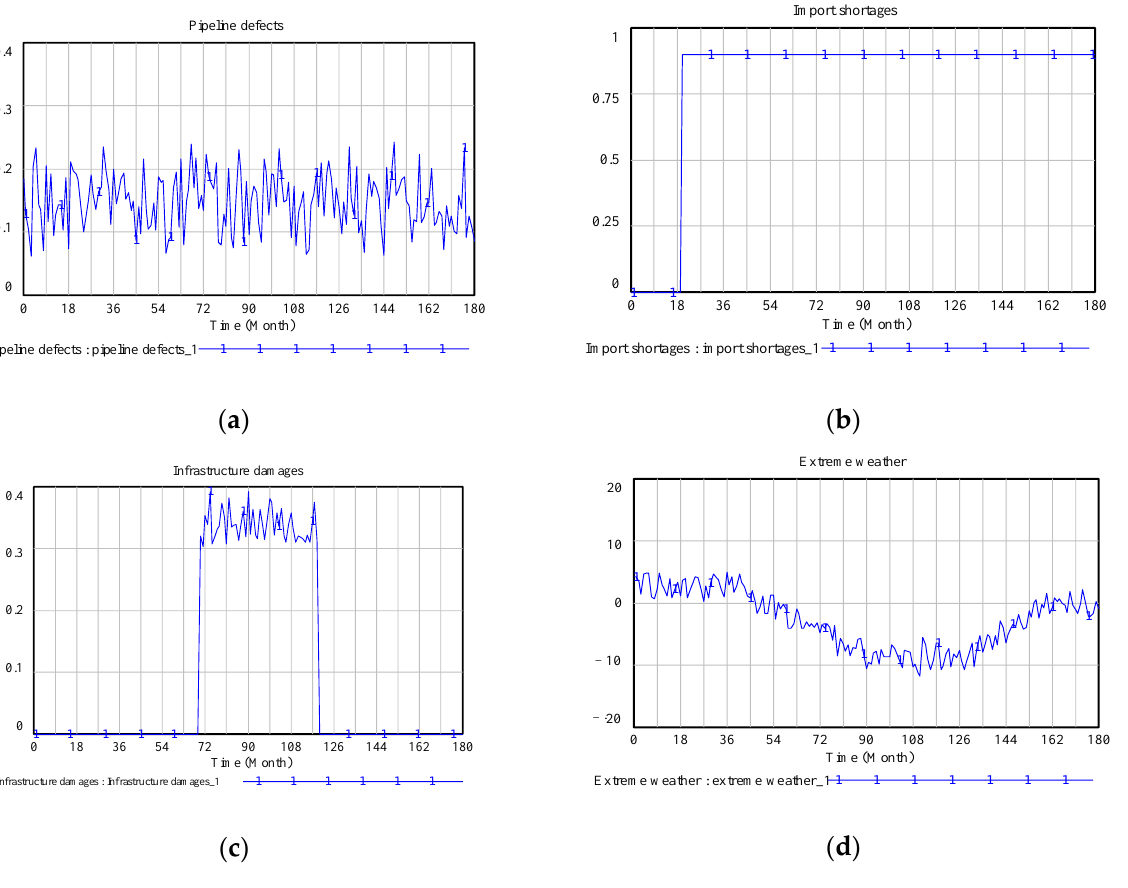
Figure 4. Effects of the experimental risk factors: ( a ) pipeline defects; ( b ) import shortages; ( c ) infrastructural damages; ( d ) extreme weather. Table 2. Market satisfaction losses induced by individual risks.